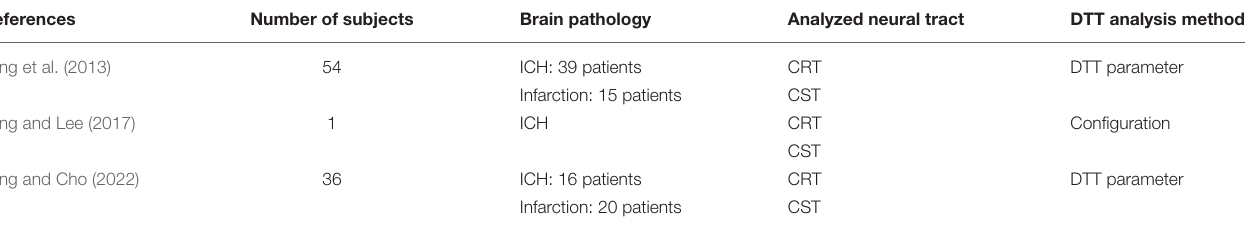
TABLE 1 | Diffusion tensor tractography studies on the role of the contra-lesional corticoreticular tract in the motor recovery of the paretic leg in stroke patients.